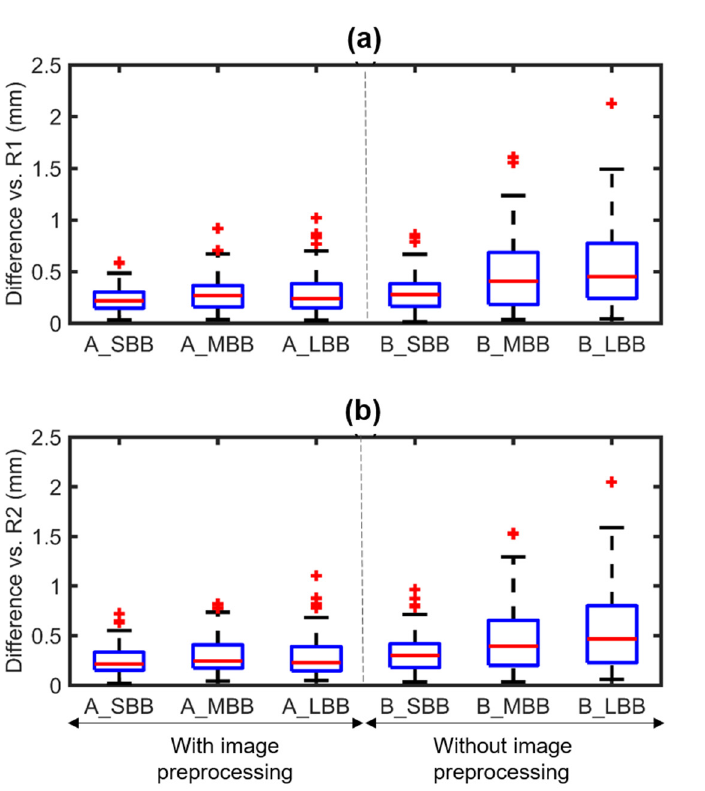
Figure 6. Box plots show the difference between the proposed method and rater 1 ( a ) or rater 2 ( b ) for different bounding box sizes (SBB, MBB, LBB) and two scenarios (A) with image preprocessing and (B) without image preprocessing. The red line in each box denotes the median value; the top and bottom hinges of the box correspond to the 25th (Q1) and 75th (Q3) percentiles, respectively. The interquartile range (IQR) is given by the interval bounded by Q1 and Q3. The minimum (Q1 − 1.5 × IQR) and maximum (Q3 + 1.5 × IQR) limits (indicated by horizontal bars) are linked to the hinges using whiskers. Data points outside these extreme values are considered potential outliers, which are indicated by the red plus signs.